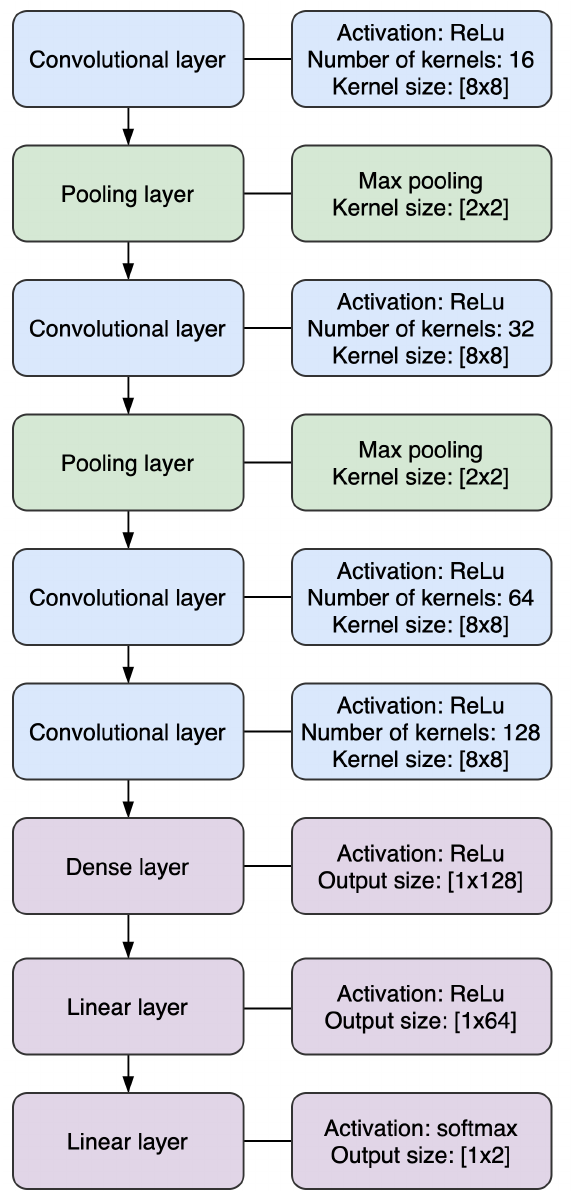
Figure 2. Architecture of the CNN used: features are extracted using convolutional and pooling layers, followed by linear